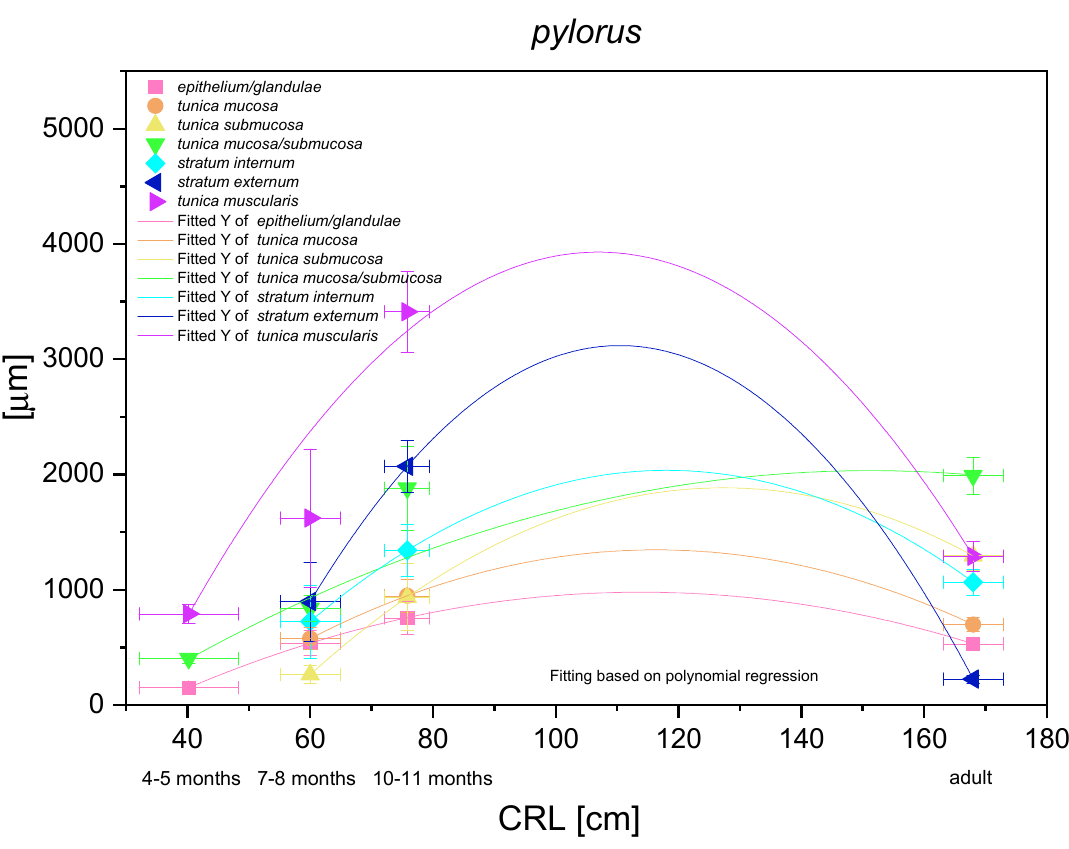
Figure 17. Histometric analysis of the stomach wall structures in the pyloric part (pylorus). The figure shows nonlinear and exponential regression curves of all metric parameters in all three age groups and the adult reference group.